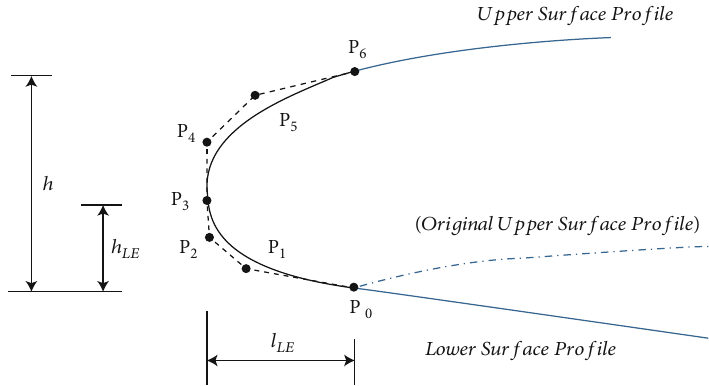
Figure 1: Illustration of key points on the blunt curves.